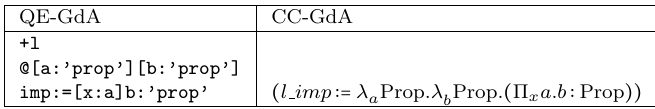
Fig. 13. The first three lines of the QE-GdA translated in the refined